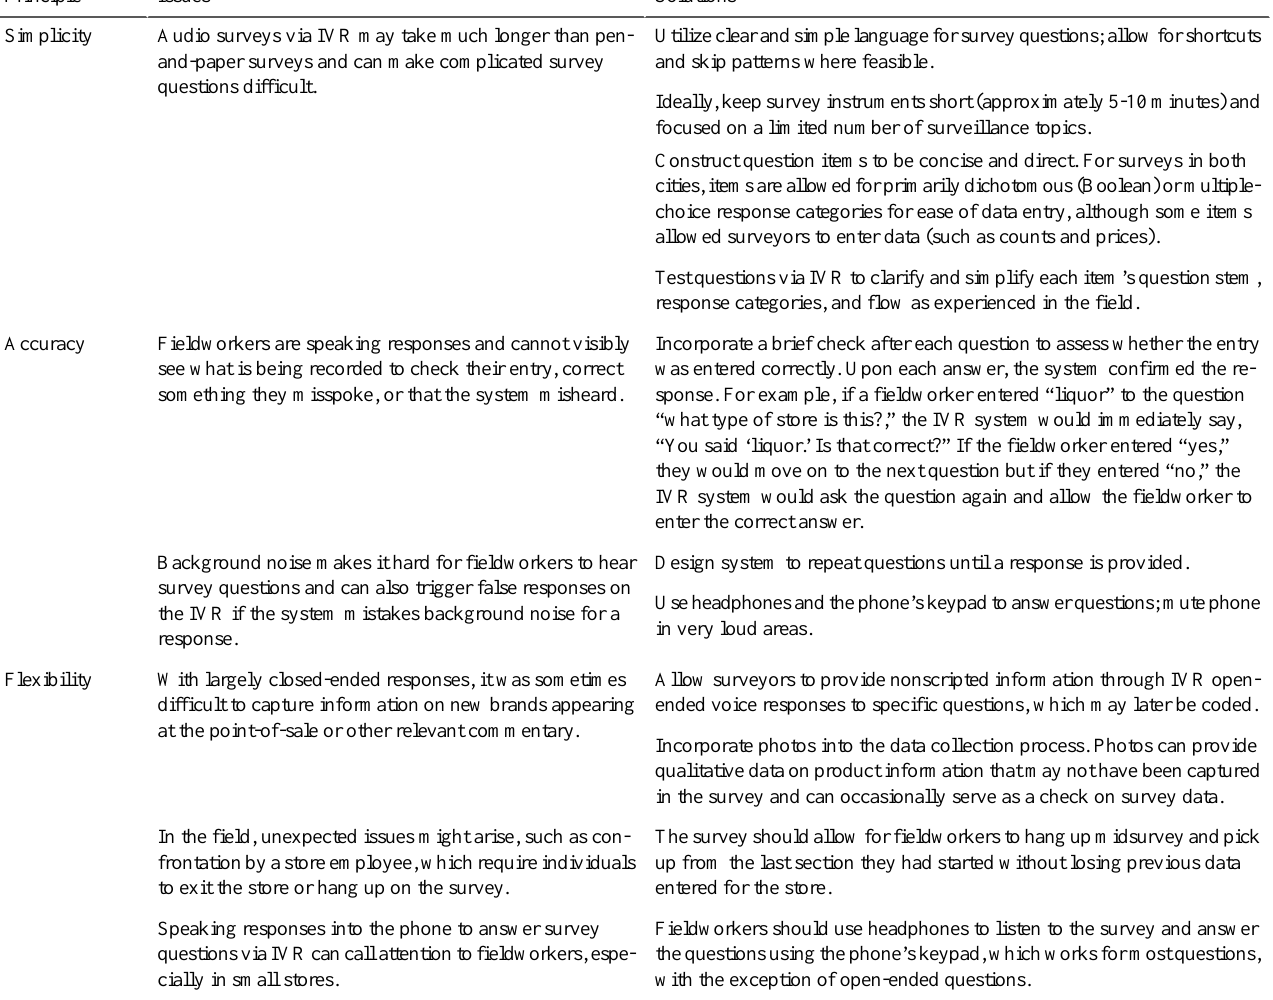
Table 1. Principles and examples for streamlining user interface components for the IVR interface.